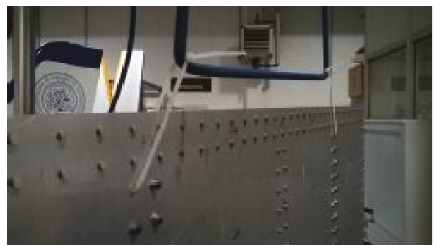
Figure 43: Detail of the hanging system.